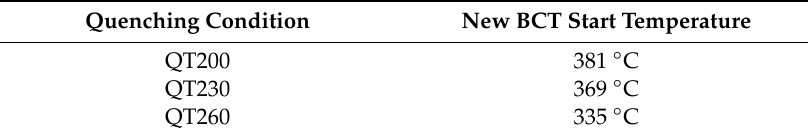
Table 1. New BCT starting temperature for the three QT conditions.